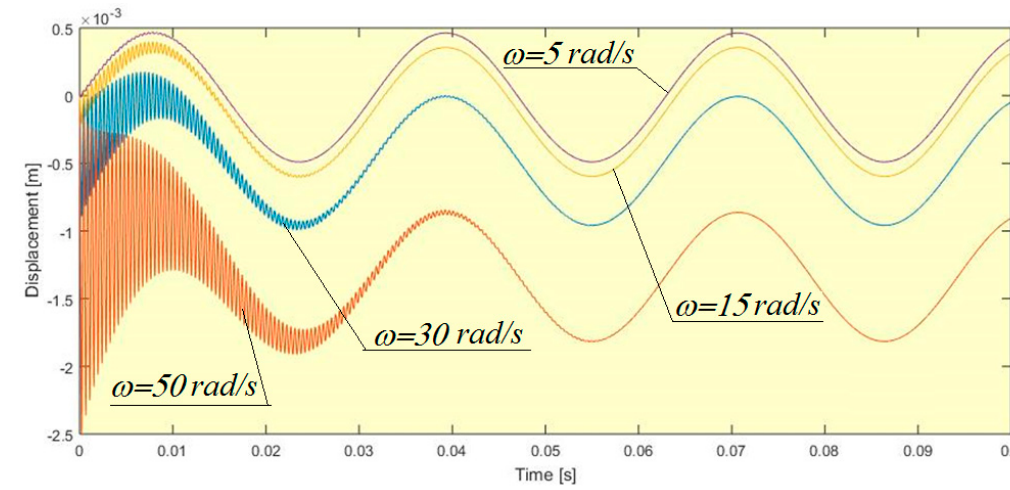
Figure 11. Cross-section area A = 0.00004 m 2 .